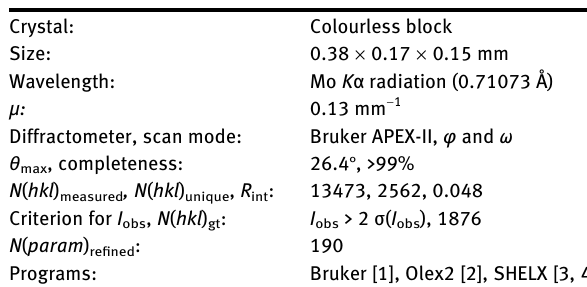
Table  : Data collection and